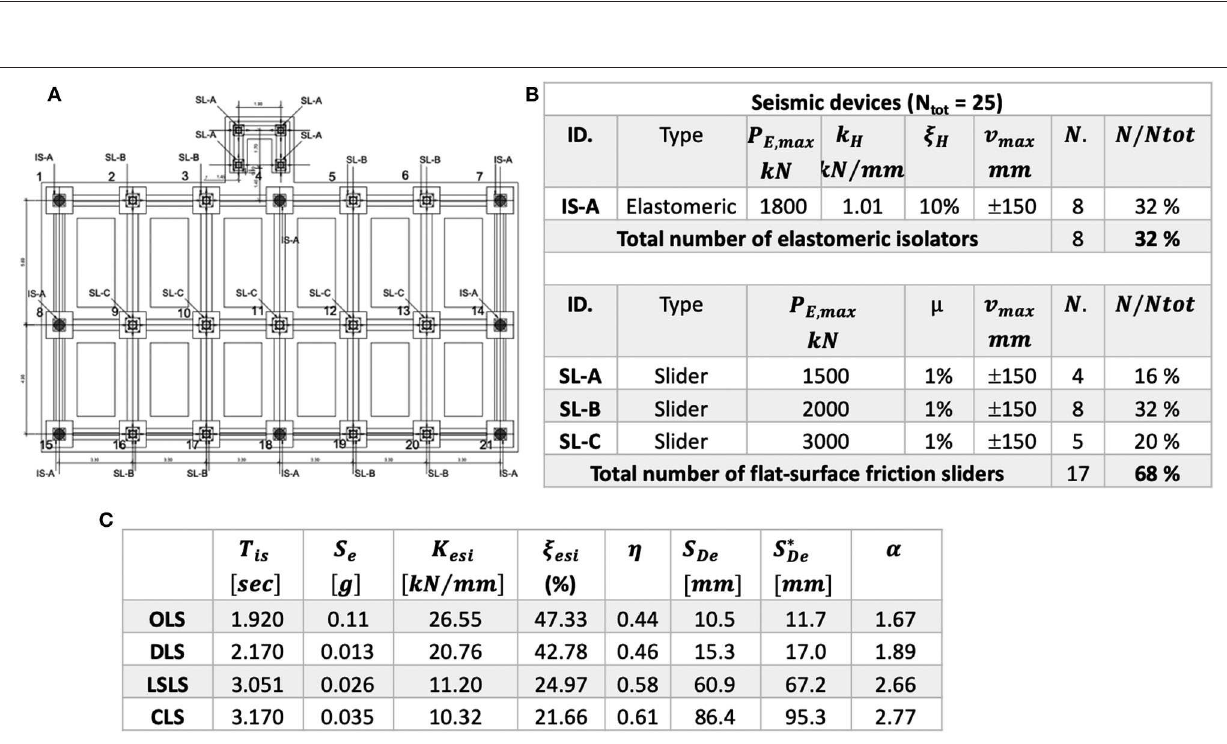
Frontiers in Built Environment |